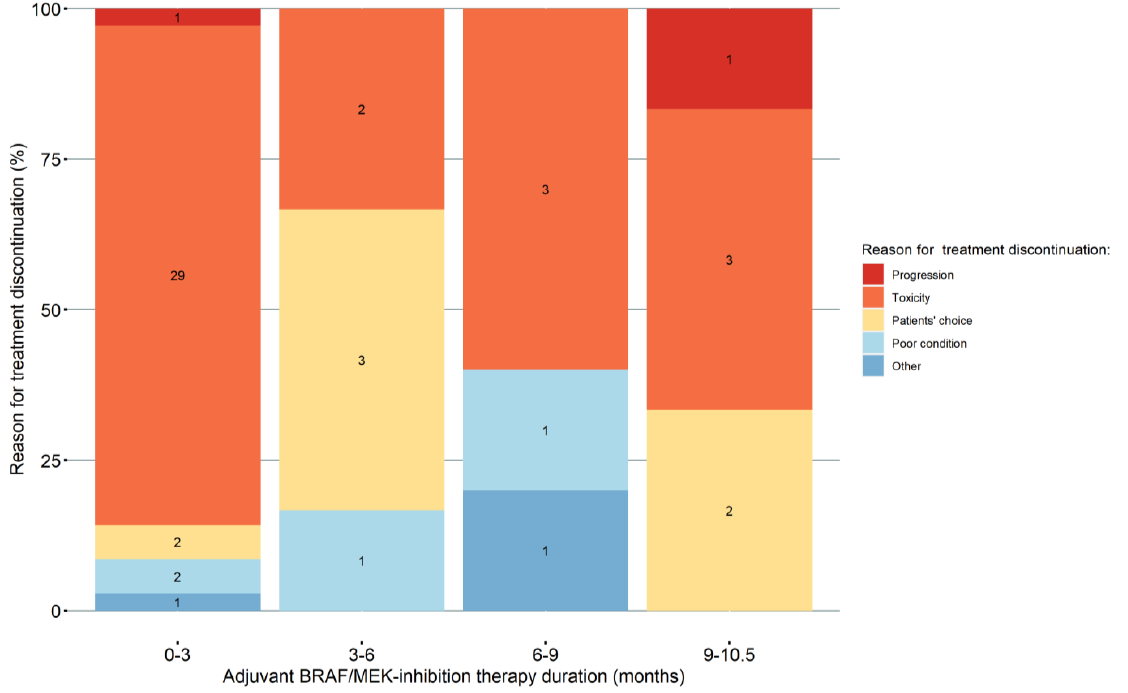
Figure 2. Timing and reason for premature treatment discontinuation of adjuvant BRAF/MEK- inhibition therapy patients. This figure depicts all patients that discontinued BRAF/MEK-treatment (n = 52). Adjuvant BRAF/MEK-inhibition therapy duration is depicted as time from starting therapy to last prescription date.